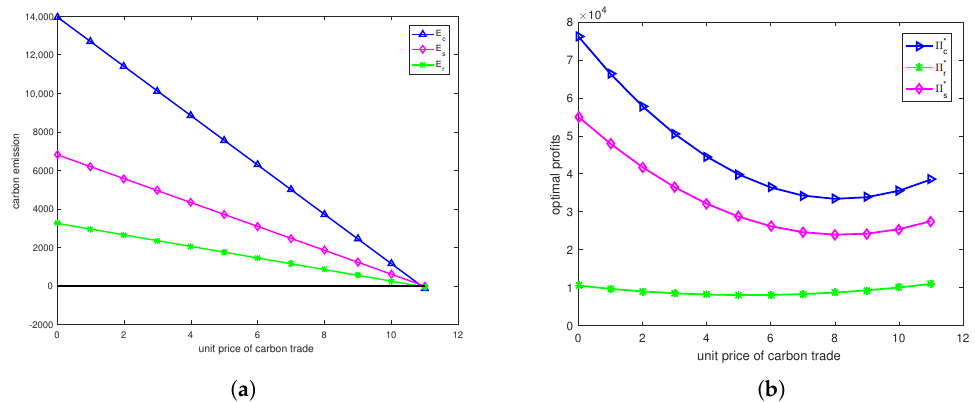
Figure 2. ( a ) The effects of unit price of carbon trade on emission. ( b ) The effects of unit price of carbon trade on profit.